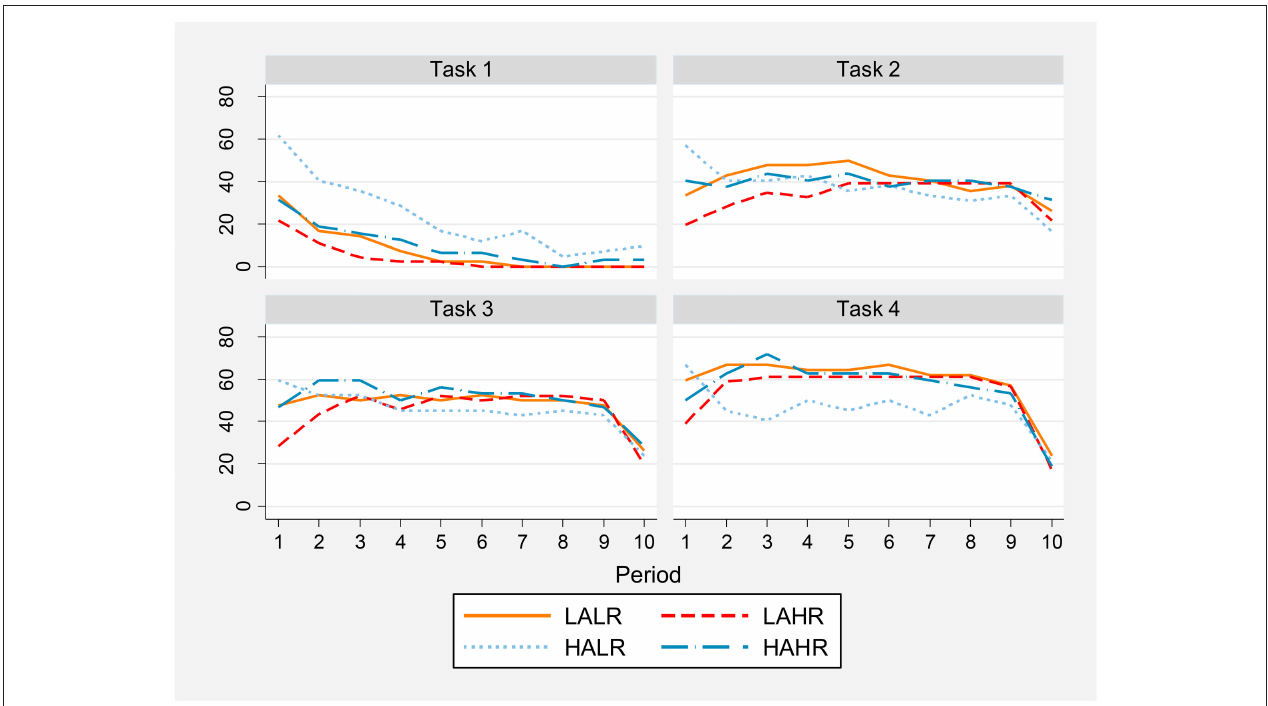
FIGURE 3 | Percentage of individuals whose belief is partner cooperation in the current period by task, period and treatment.